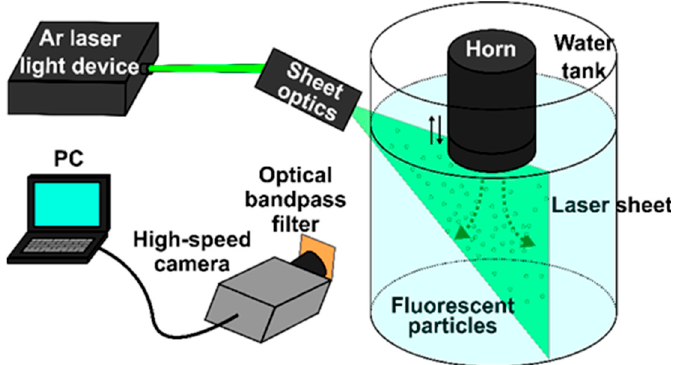
Figure 1. Experimental setup for Particle Image Velocimetry (PIV) measurements.